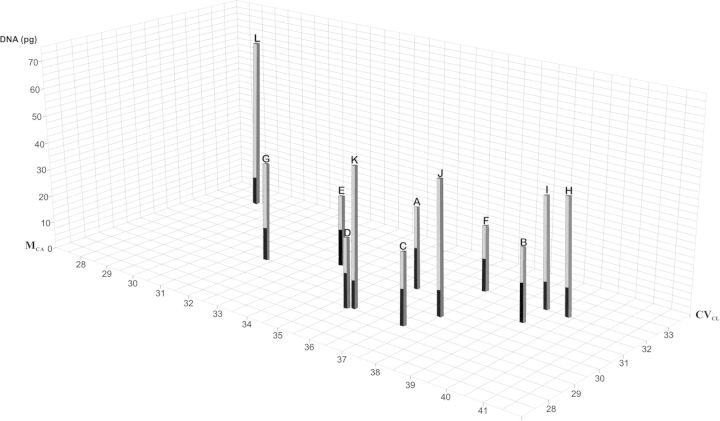
Asymmetry parameters (MCA and CVCL) plotted against DNA content. The bars represent the total DNA amount (2C) and the black zone indicates the basic DNA amount (1Cx). (A) H. solandriflorum (2x), (B) H. tucumanum (2x), (C) H. parodii (2x), (D) H. correiense (2x), (E) H. rutilum (2x), (F) H. morelianum (2x), (G) H. puniceum (3x), (H) H. rutilum (4x), (I) H. blossfeldiae (4x), (J) H. cybister (5x), (K) H. rutilum (5x) and (L) H. puniceum (6x). MCA, mean centromeric asymmetry; CVCL, coefficient of variation of chromosome length.